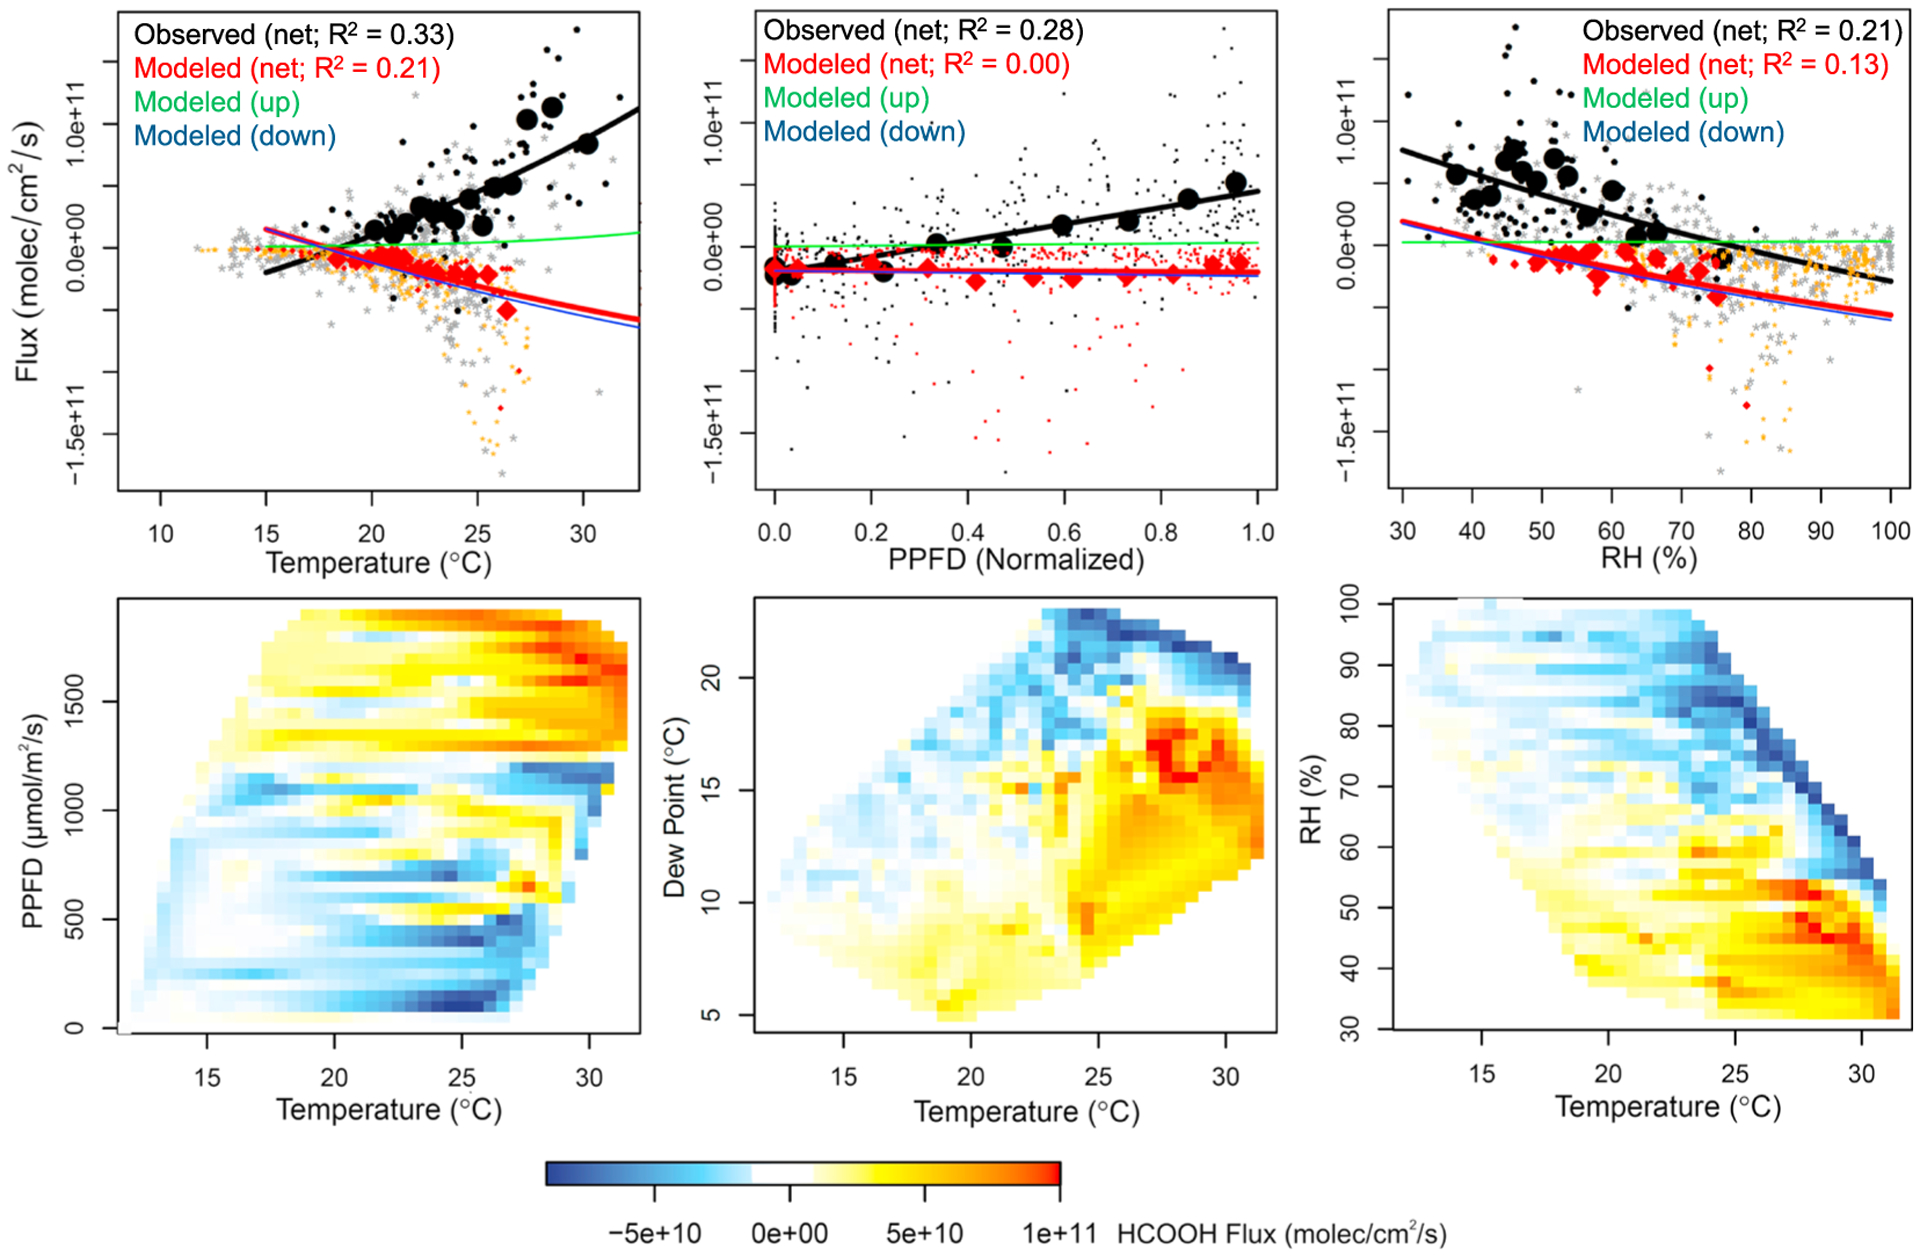
Dependence of canopy HCOOH fluxes on environmental drivers. The top row shows measured (black) and modeled (red) HCOOH fluxes plotted as a function of temperature, light (photosynthetic photon flux density [PPFD]), and relative humidity (RH). For the temperature and RH plots, daytime (PPFD > ~1,500 μmol/m2/s; black and red) and other (gray and orange) values are indicated separately. The large symbols and fit lines show the mean fluxes binned by quantile of the independent variable. The thin green and blue lines show the corresponding dependencies for the modeled gross upward and downward HCOOH fluxes, respectively. The bottom row shows curtain plots of the measured HCOOH fluxes as a function of temperature, light, RH, and dew point.